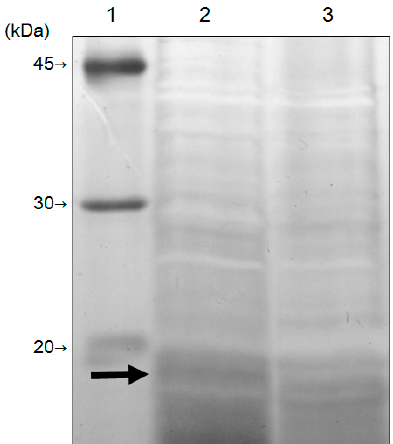
Figure 8. Sodium dodecyl sulfate-polyacrylamide gel electrophoresis (SDS-PAGE) of the extracts from F. oxysporum before (lane 2) and after (lane 3) treatment of a 5 mM Cd (+) Se IV (+) solution (pH 7.5) at 25 °C. Lane 1 showed the marker. Black arrow indicated that the specific band in the extracts from F. oxysporum before treatment of a 5 mM Cd (+) Se IV (+) solution (pH 7.5) at 25 °C.